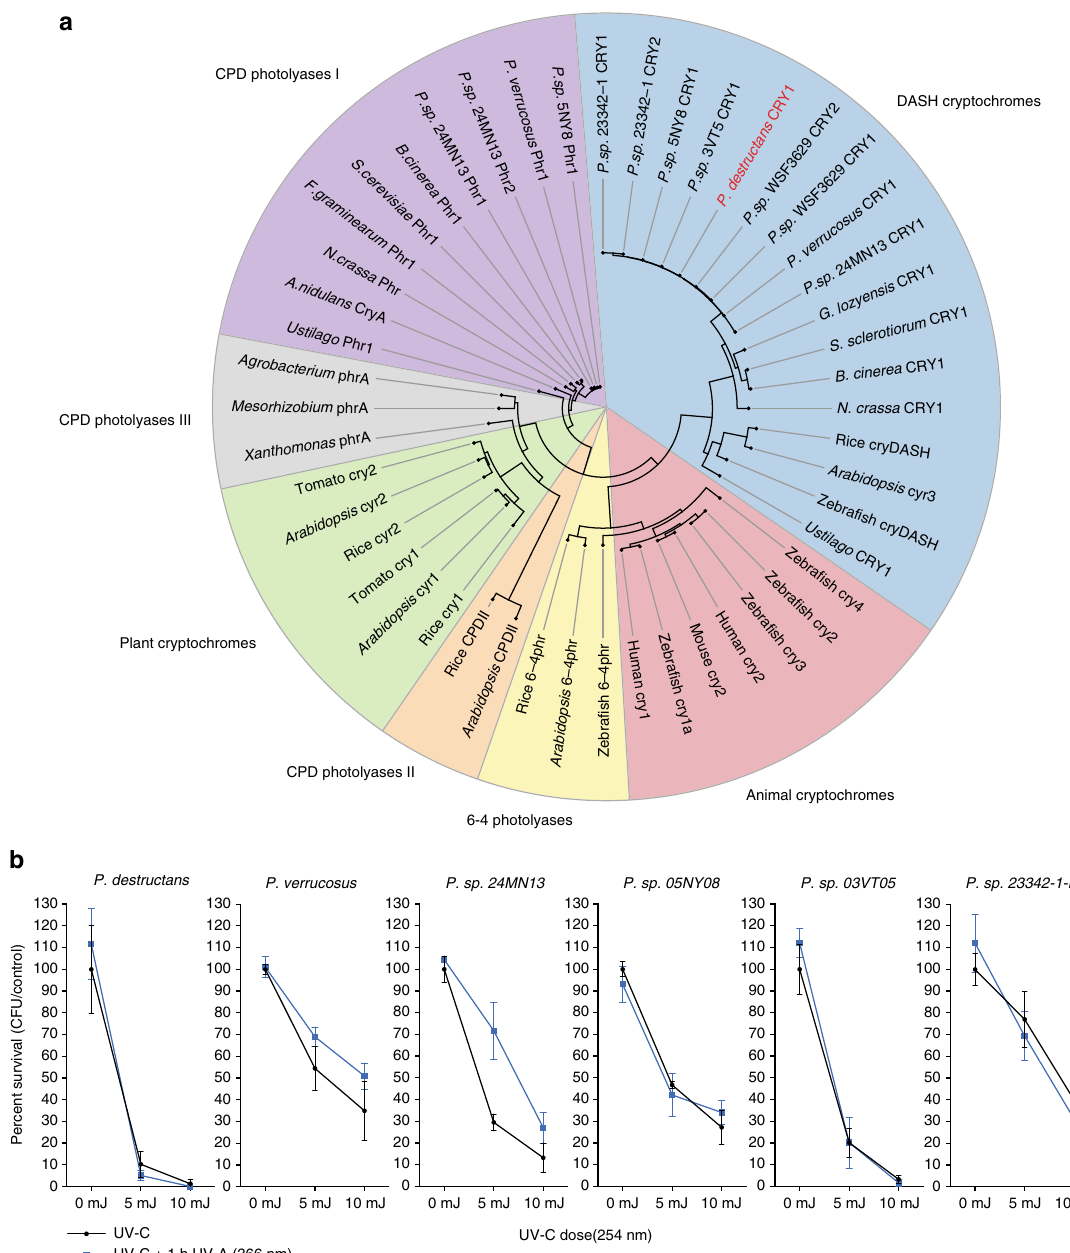
Fig. 5 Blue light-mediated photoreactivation DNA repair is not functional in P. destructans . a Characterization of photolyases in Pseudogymnoascus species based on protein alignment and maximum likelihood phylogeny of well-characterized enzymes. Pseudogymnoascus destructans lacks a canonical CPD photolyase I, although it harbors a cyr-DASH photolyase (VC83_00225). The genomes of Pseudogymnoascus verrucosus , P. sp. 24MN13, and P. sp. 05NY08 contain a CPD photolyase I, whereas all species studied contain at least one cry-DASH ortholog. Proteins identi fi ed in ref. 66 were used for phylogenetic comparison of DNA photolyases. b Photoreactivation experiments comparing survival of germinating conidia exposed to varying doses of UV-C (254 nm) followed by treatment with UV-A (366 nm) for 1 h indicate that only P. verrucosus and P. sp. 24MN13 display increased survival attributed to the activity of CPD photolyase I. No change in survival was detected in P. destructans or the other three nonpathogenic Pseudogymnoascus species tested. Interestingly, P. sp. 05NY08 did not show an increase in CFU survival despite the fungus harboring a CPD photolyase I enzyme. A similar phenomenon occurs in Aspergillus nidulans , where there was no change in CFU survival in photoreactivation assays in wild-type background, despite the presence of the functional CryA gene (CPD photolyase I) 67 . CFU assays were performed in biological triplicate ( n = 3) and error bars represent standard topoisomerase I function, which results in stalled replication UV light damages DNA by inducing the formation of forks; thus, lethal mutations can accumulate during S phase 47 . On pyrimidine dimers (cyclobutane dimers and 6-4 photoproducts), while MMS alkylates guanine and adenine nucleotides 46 . the other hand, 4-NQO induces single base pair mutations with a Damaged or modi fi ed nucleotides result in mispairing and/or bias toward guanine to thymine transversions 48 and thus can replication fork blockage and therefore can result in mutations. cause direct mutagenesis. To combat DNA damage, organisms Camptothecin ’ s mode of action is similar as it inhibits have employed several DNA repair pathways, including